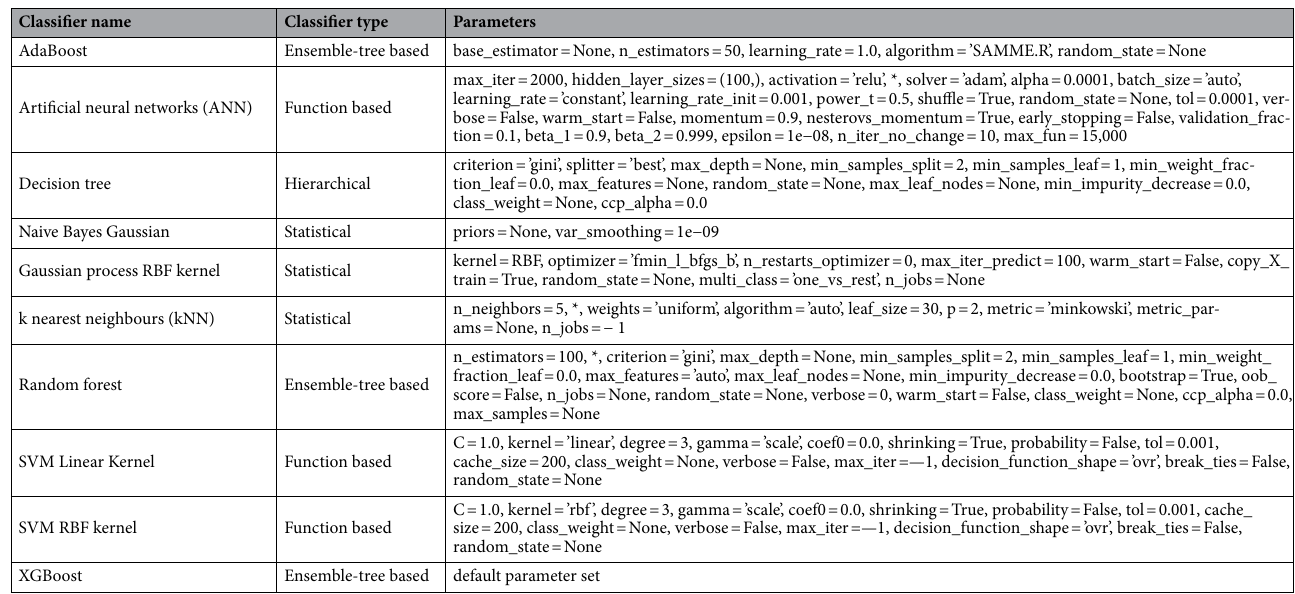
Table 2. The classifiers used in the